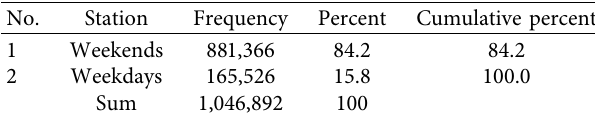
Table 7: Percentage of weekend in this data.